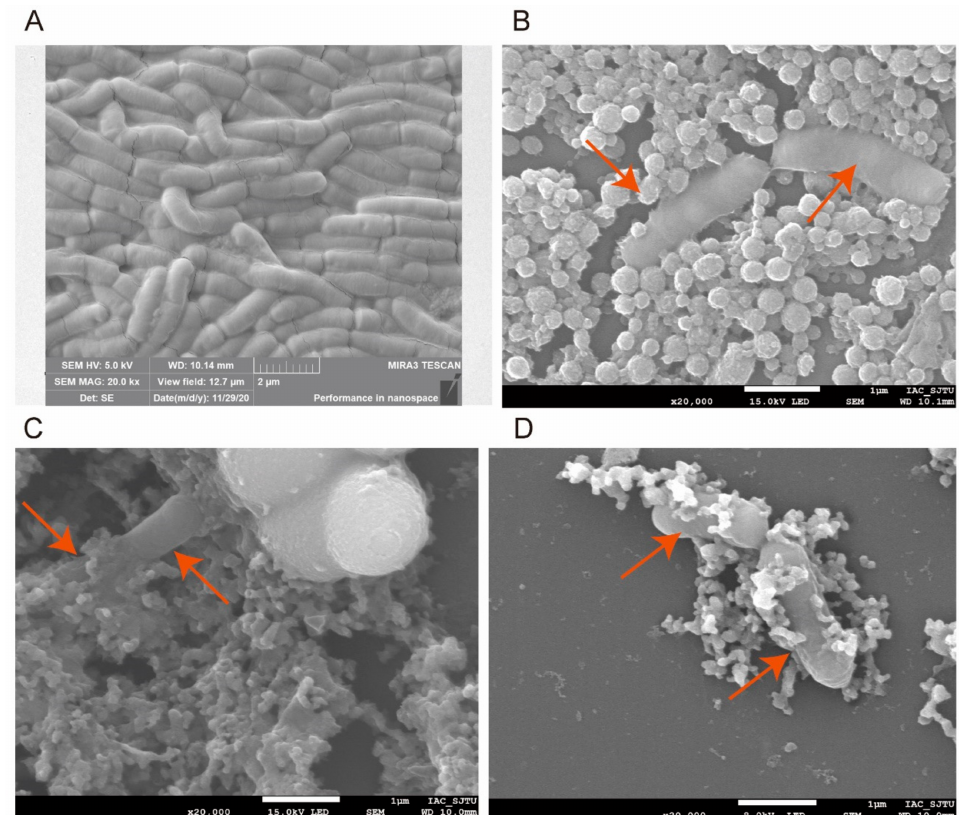
Figure 5. Morphology of the interaction of protectants and L. casei K17 cell by scanning electron micrograph. ( A ) Morphology of L. casei K17 cell without the addition of protectant. ( B ) Morphology of L. casei K17 cell with monolayer protectant. ( C ) Morphology of L. casei K17 cell with bilayer protectant. ( D ) Morphology of L. casei K17 cell with trilayer